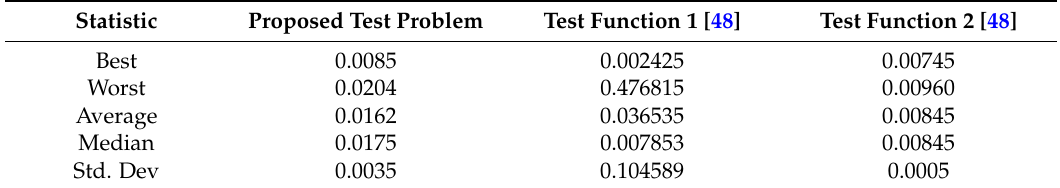
Table 9. The generational distance results of MOPSO with proposed test problem and other test problem solved in